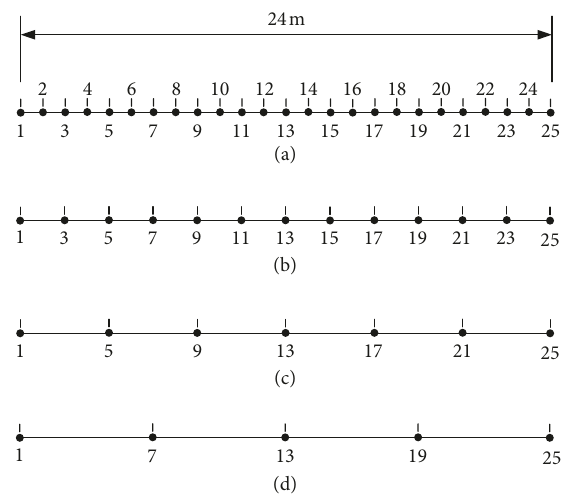
Figure 14: The applied sensors and corresponding